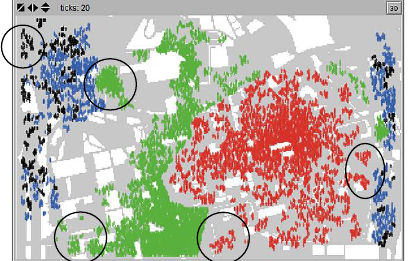
Figure 10-1: Segregation pattern at a satisfaction level of 70% and radius 2 pixel